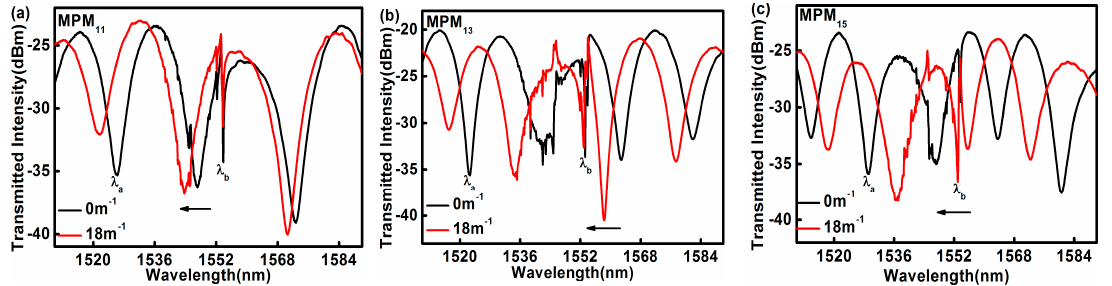
Figure 5. The spectra shift for curvatures of 0 m − 1 and 18 m − 1 : ( a ) MPM 11 ; ( b ) MPM 13 ; and ( c ) MPM 15 .